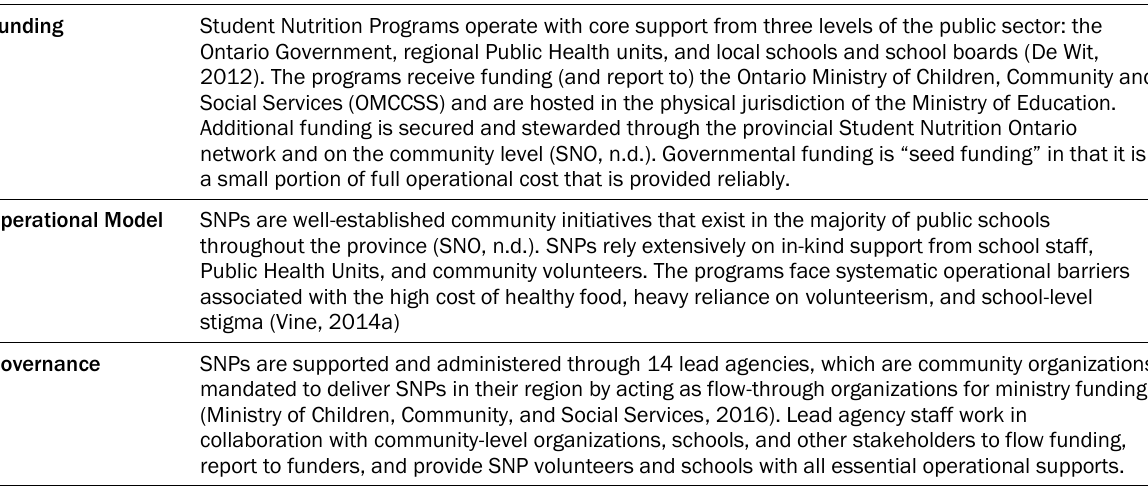
Table 1. Student Nutrition Programs (SNPs) in Ontario